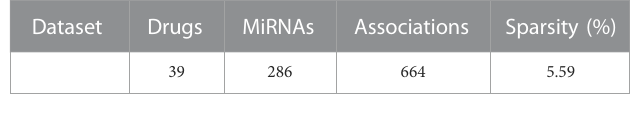
TABLE 1 The dataset used in GNMFDMA for